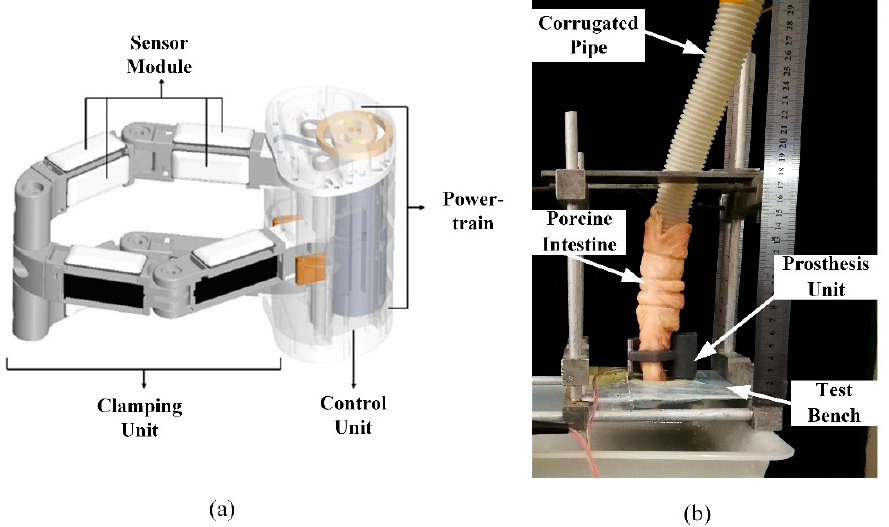
Figure 2. Schematic diagram of AAS system with sensor system ( a ) and work principle ( b ).